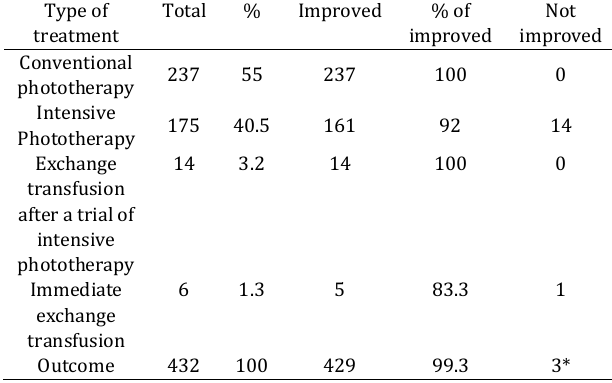
Kinds of treatment and